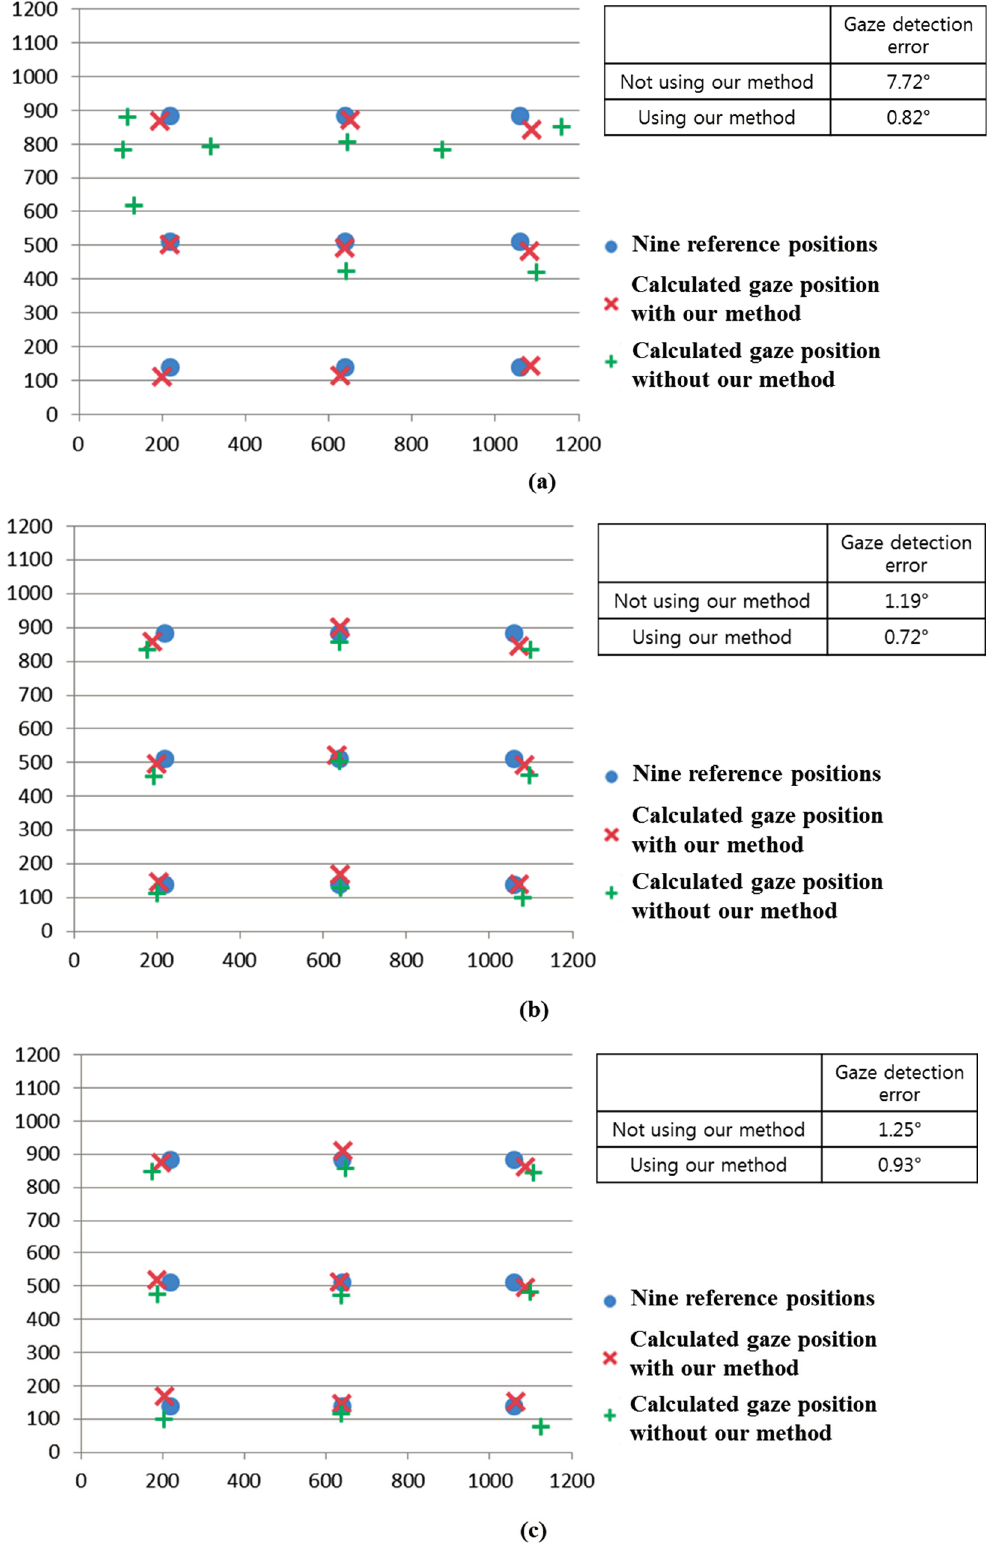
Figure 30. Comparisons of gaze detection errors without and with our method of Section 2.5 in various positions of sunlight relative to user’s face ( a ) when sunlight is positioned in front of user’s face; ( b ) when sunlight is positioned in the right side of user’s face; ( c ) when sunlight is positioned in the left side of user’s